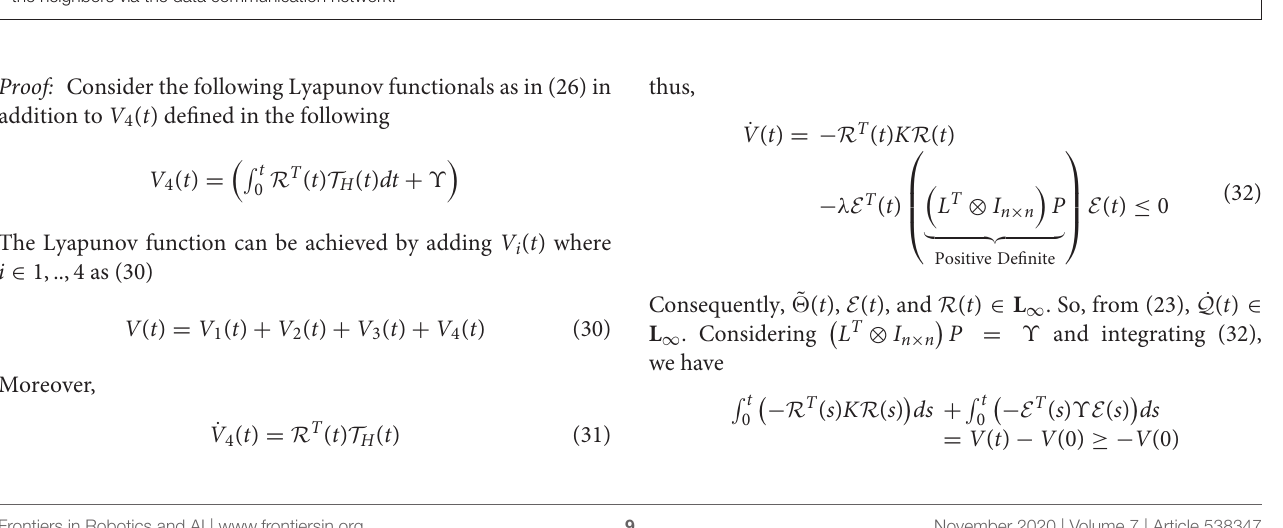
FIGURE 3 | Diagram of the proposed method for decentralized controller. Part (A) shows the general overview of the decentralized controller. Part (B) depicts the inside of each block of the part (A) . In this diagram, the schematic of the local controller (35) is depicted. This controller consists of a local controller plus the multiagent based controller (37). To implement the latter one, the vector R i is received from the adjacent agents of the i th manipulator, containing their intermediate A ( i ) variables r j ( j ). On the other hand, the information about the i th position ( q i ) and the i th intermediate variable ( r i ) related to the i th robot itself, are shared with ∈ { } the neighbors via the data communication